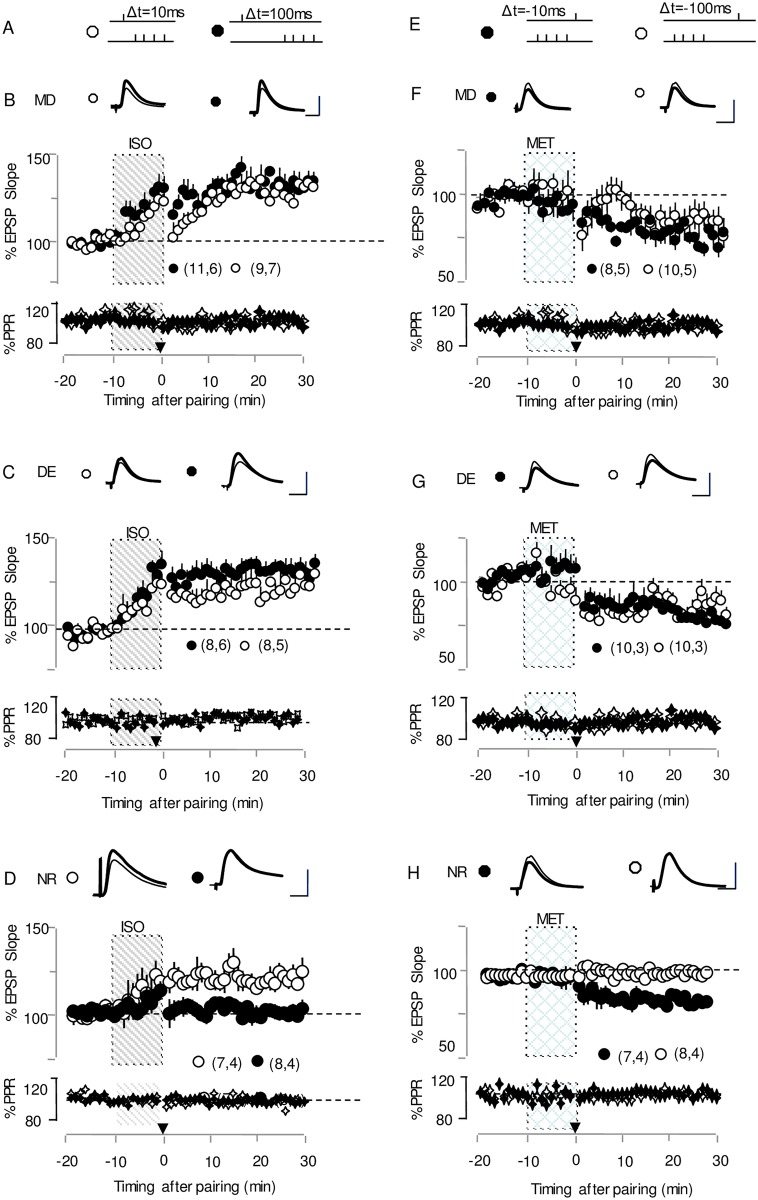
Both monocular deprivation and dark exposure expand the temporal windows for tLTP and tLTD.(A) Conditioning paradigms for tLTP; (E) Conditioning paradigms for tLTD; (B) Bath application of the β-adrenergic agonist isoproterenol (Iso:10 μM, gray bar) increases EPSP slope (open circles) and allows induction of LTP with pairing at +10 ms (filled circles) and +100ms(open circles) in cells from monocular deprived mice. (C)Pairing at +10 ms (open circles) and +100ms (filled circles) in the cells from dark-reared mice result in the induction of LTP. (D) In cells from normal reared mice, isoproterenol promotes the induction of tLTP when pre-then-post delay is 10 ms, but not when it is 100ms. (F) In the presence of the α1 adrenergic agonist methoxamine (Metox: 5 μM for 10 min, grid bar) pairing with -10 ms (filled circles) and -100ms (open circles) induces LTD in cells from monocular-deprived mice. (G)Bath application of the α1 adrenergic agonist methoxamine allows induction of LTD with -10ms (solid circles) or −100 ms (open circles) pairing in cells from dark-reared mice. (H)In cells from normal reared mice,tLTD can be induced with methoxamine when post-then-pre delay is -10ms,but no tlTD is observed when the delay is -100ms. Traces (top) are average of ten consecutive responses recorded before (thin) and after pairing (thick). Note no Changes in pair pulse ratio (PP Ratio) (Bottom graph) for pairing. Plotted data is average ± SEM; Calibration:6 mV, 10 ms.